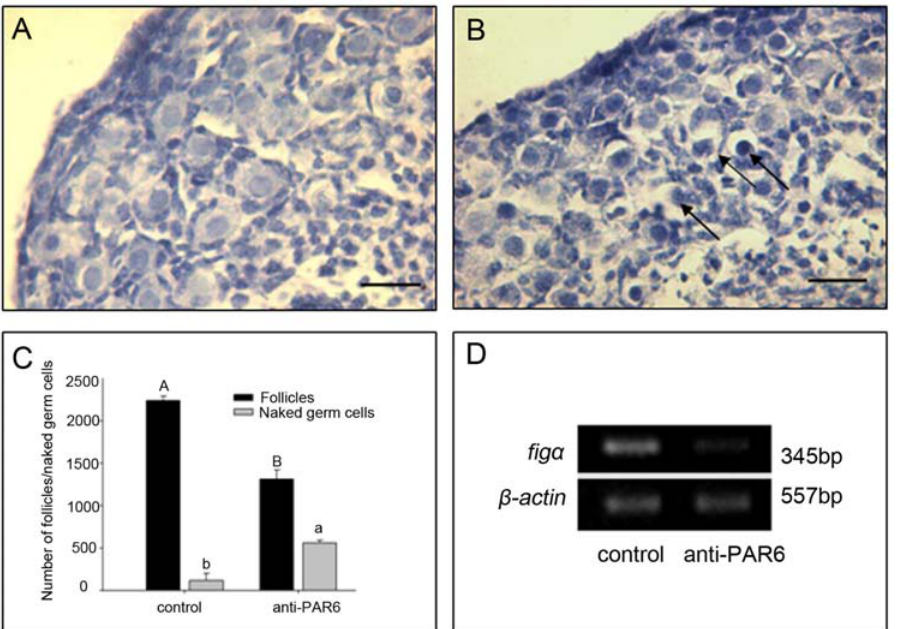
Figure 3. The effect of anti-PAR6 antibody on the follicle formation. 15.5 dpc ovaries were treated with anti-PAR6 antibody or goat IgG (control ) for 7 days, and then the shape (A, B), the numbers (C) of follicles and naked germ cells, and the mRNA expression of the germ cell-specific transcript factor Fig a (D) were examined. The shape and number of follicles in anti-PAR6 antibody treatment were abnormal compared with that of control (arrows noted the defective follicles). Bar=20 m m. Each follicular data came from five ovaries, and RT-PCR was repeated at least three times with similar results. Different letters were considered significant (P , 0.05) respectively.